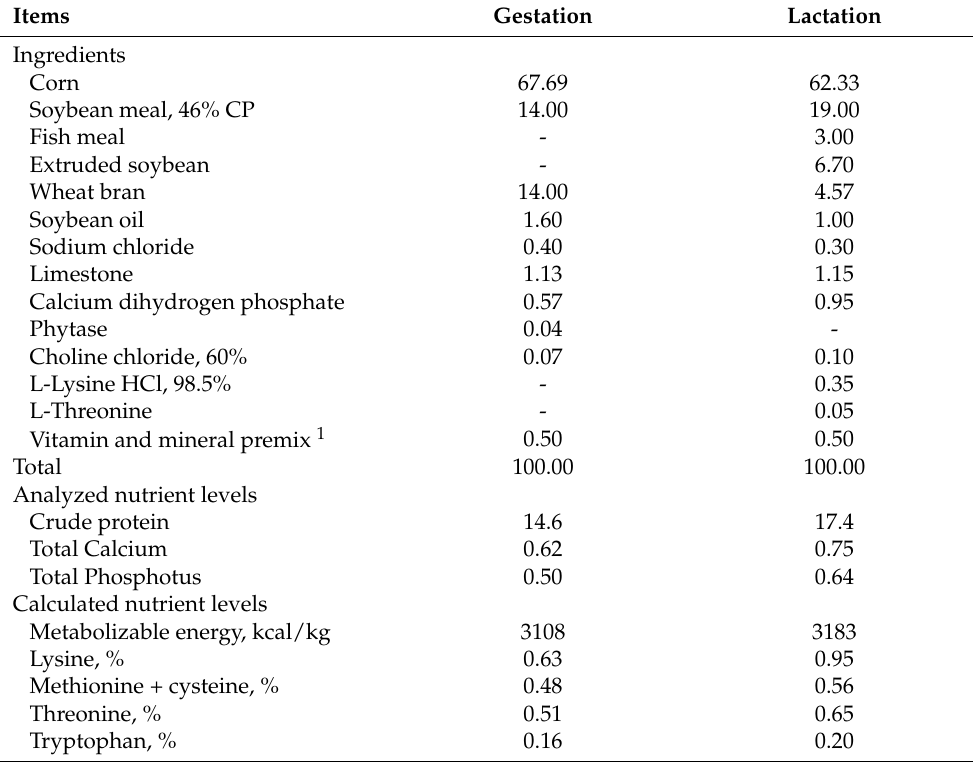
Table 1. Ingredient compositions and nutrient levels of gestation and lactation diets (%, as-fed